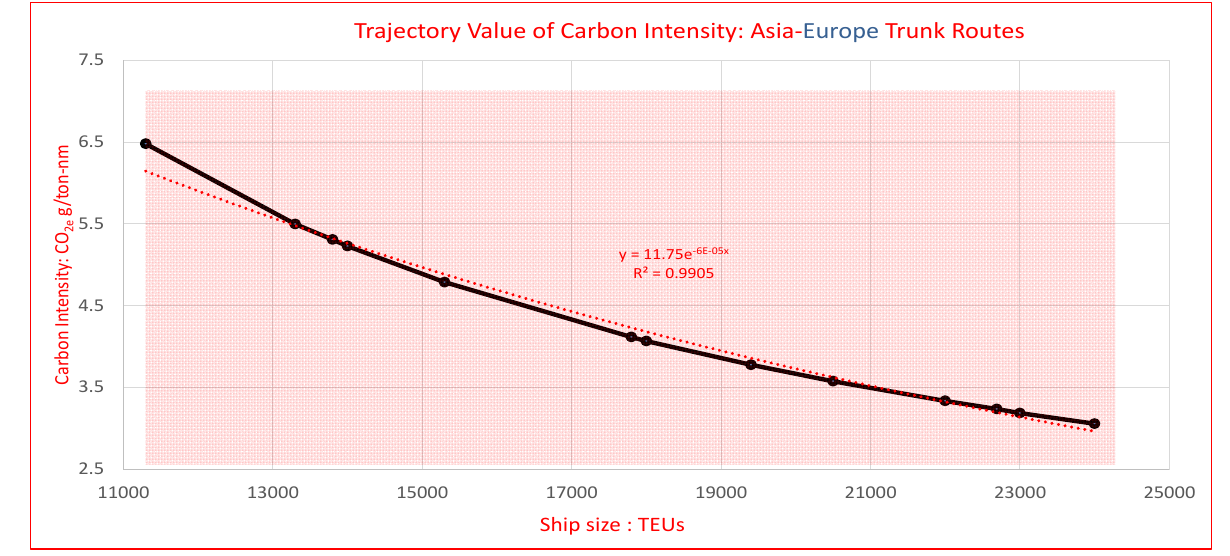
Figure 2. The Carbon Intensity against Ship Size of Route A.